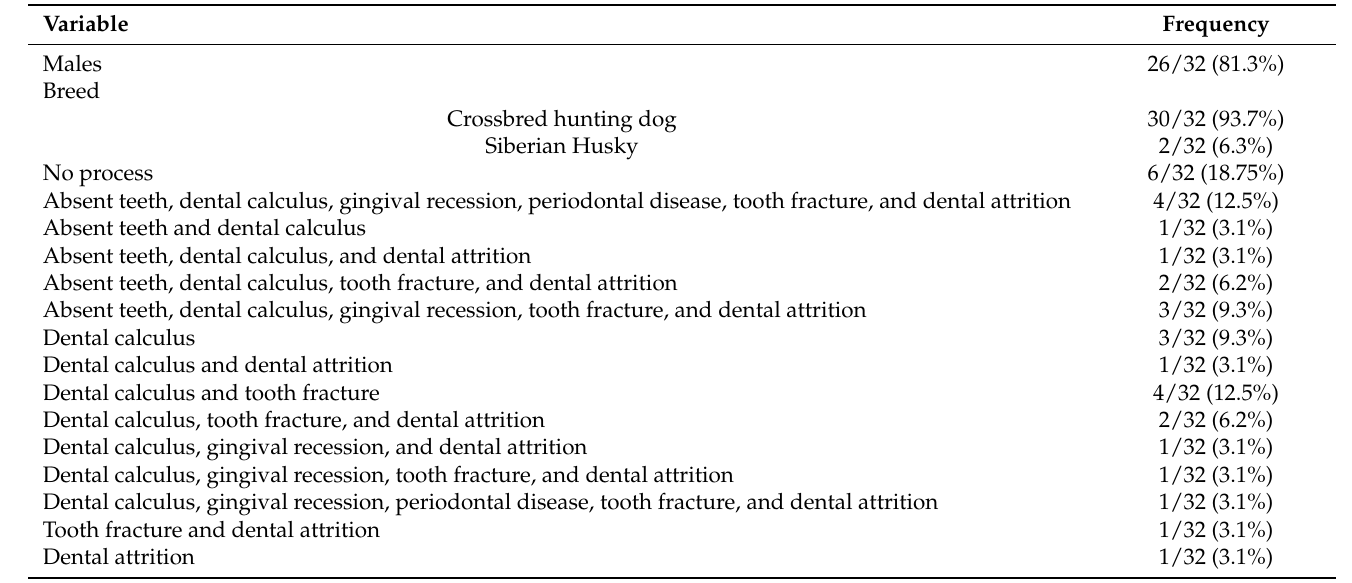
Table 1. Characteristics of studied animals.